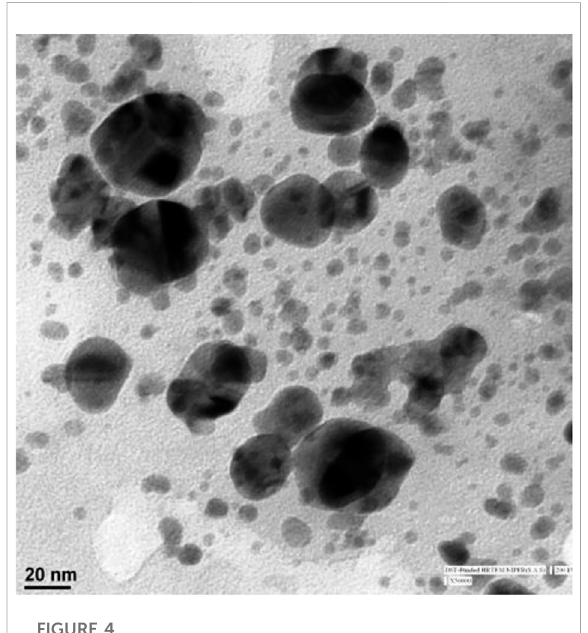
FIGURE 4 TEM image of synthesized silver nanoparticles.